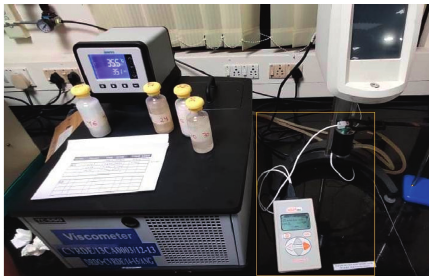
Figure 1: Experimental setup with viscometer and KD2 pro- thermal property